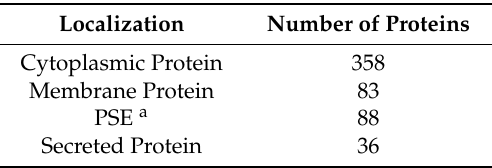
Table 2. Subcellular location of Treponema pallidum (Tp) strain